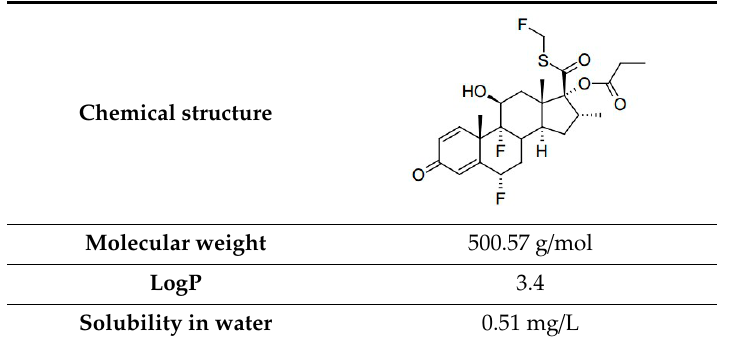
Table 1. Physical properties of fluticasone propionate (FTZ).